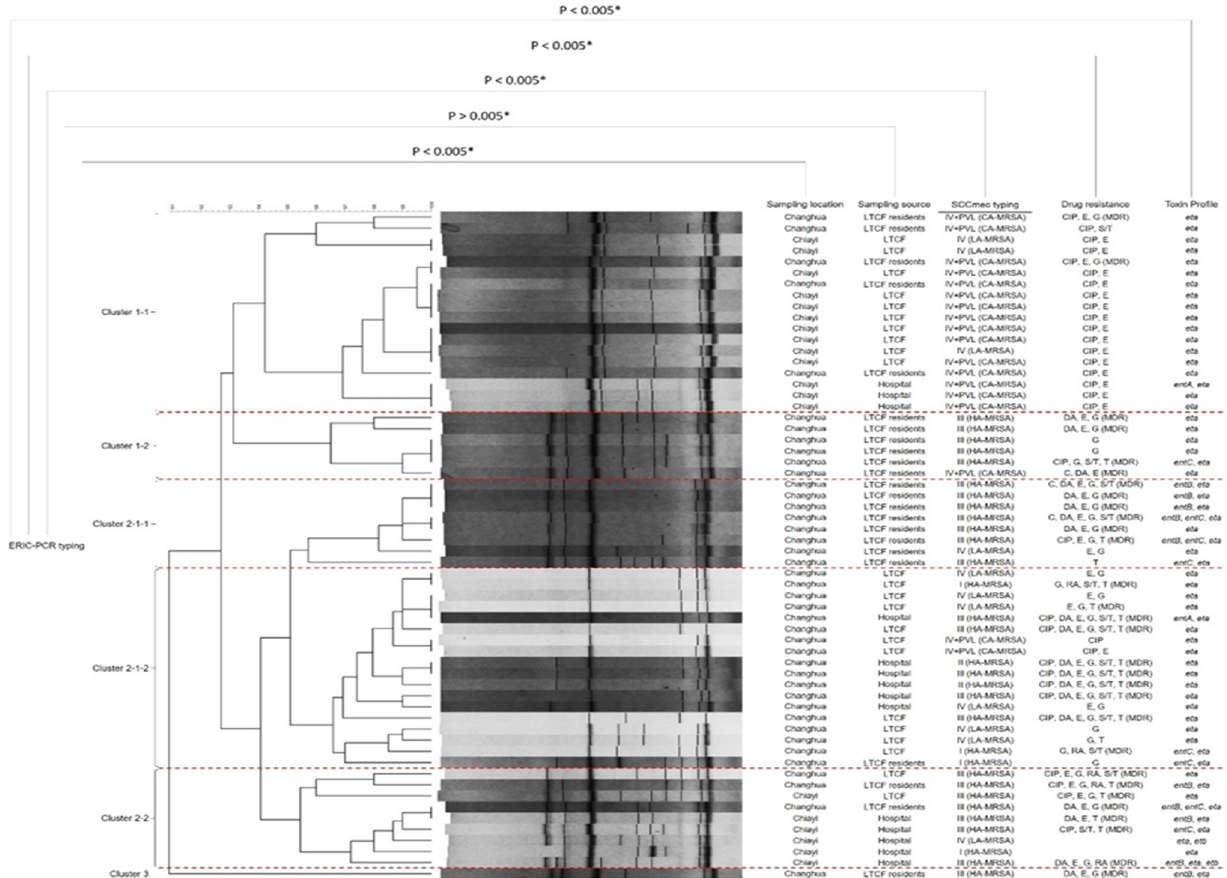
Figure 1. Genetical diversity of MRSA strains by ERIC-PCR combined with MDR pattern, SCCmec typing and toxin profile.